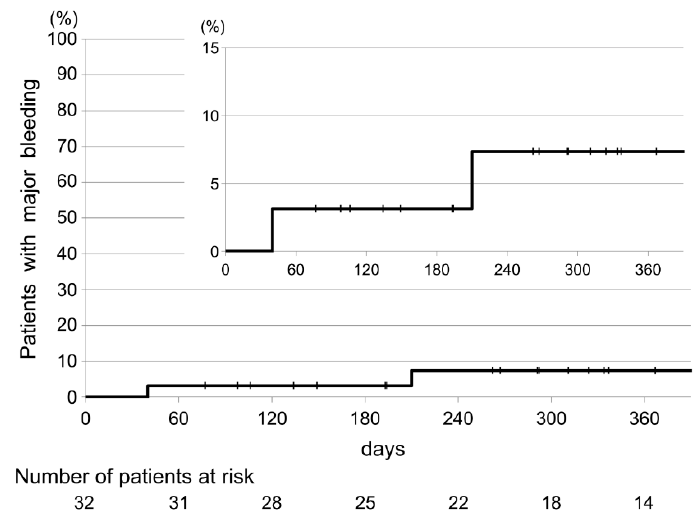
Figure 6. Kaplan–Meier cumulative-event rates for major bleeding.